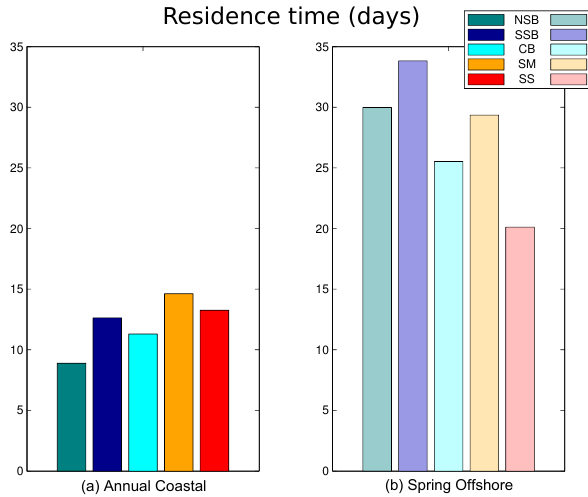
Figure 15. (a) Annual mean residence time (in days) of upwelled water masses in the coastal boxes and (b) spring average (March– May) residence time (in days) of upwelled water masses in the offshore boxes. Each colour corresponds to a box (see legends in Fig. 2 for coastal and Fig. 8 for offshore boxes): northern Saha- ran Bank (NSB), southern Saharan Bank (SSB), Cape Blanc area (CB), Senegalo-Mauritanian region (SM) and southern Senegal re- gion